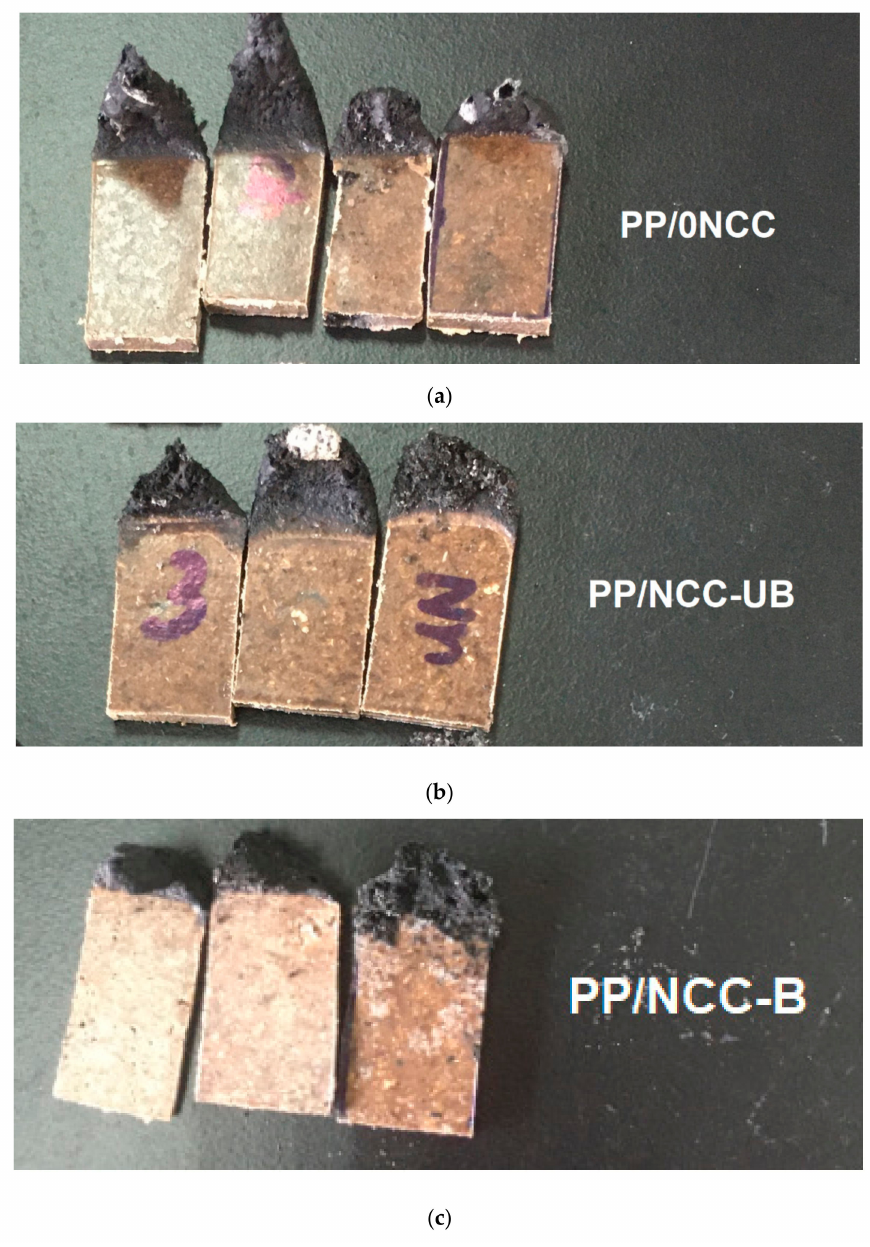
Figure 10. The images of ( a ) PP/0NCC, ( b ) PP/NCC-UB and ( c ) PP/NCC-B. On the contrary, the burning rate of the PP/NCC-B was observed to have the highest value compared to PP/0NCC and PP/NCC-UB. The failure related to the homogeneity of the filler in the polymer matrix and the existence of sulphate by-products grafted on the NCC surface might explain the unsatisfactory properties. The difference in the surface energy of nanocellulose, together with their intrinsic tendency to agglomeration, led to poor interfacial adhesion and inhomogeneous dispersion of nanocellulose, thus reducing its properties [58]. It is suggested that only 1 wt.% of MAPP in the system was incapable of improving the bonding between NCC-B and polymer matrixes. Meanwhile, the presence of the sulfate group affected NCC-B more severely compared to NCC-UB, which might be due to the existence of lignin. The sulfate group might act as a catalyst to reduce